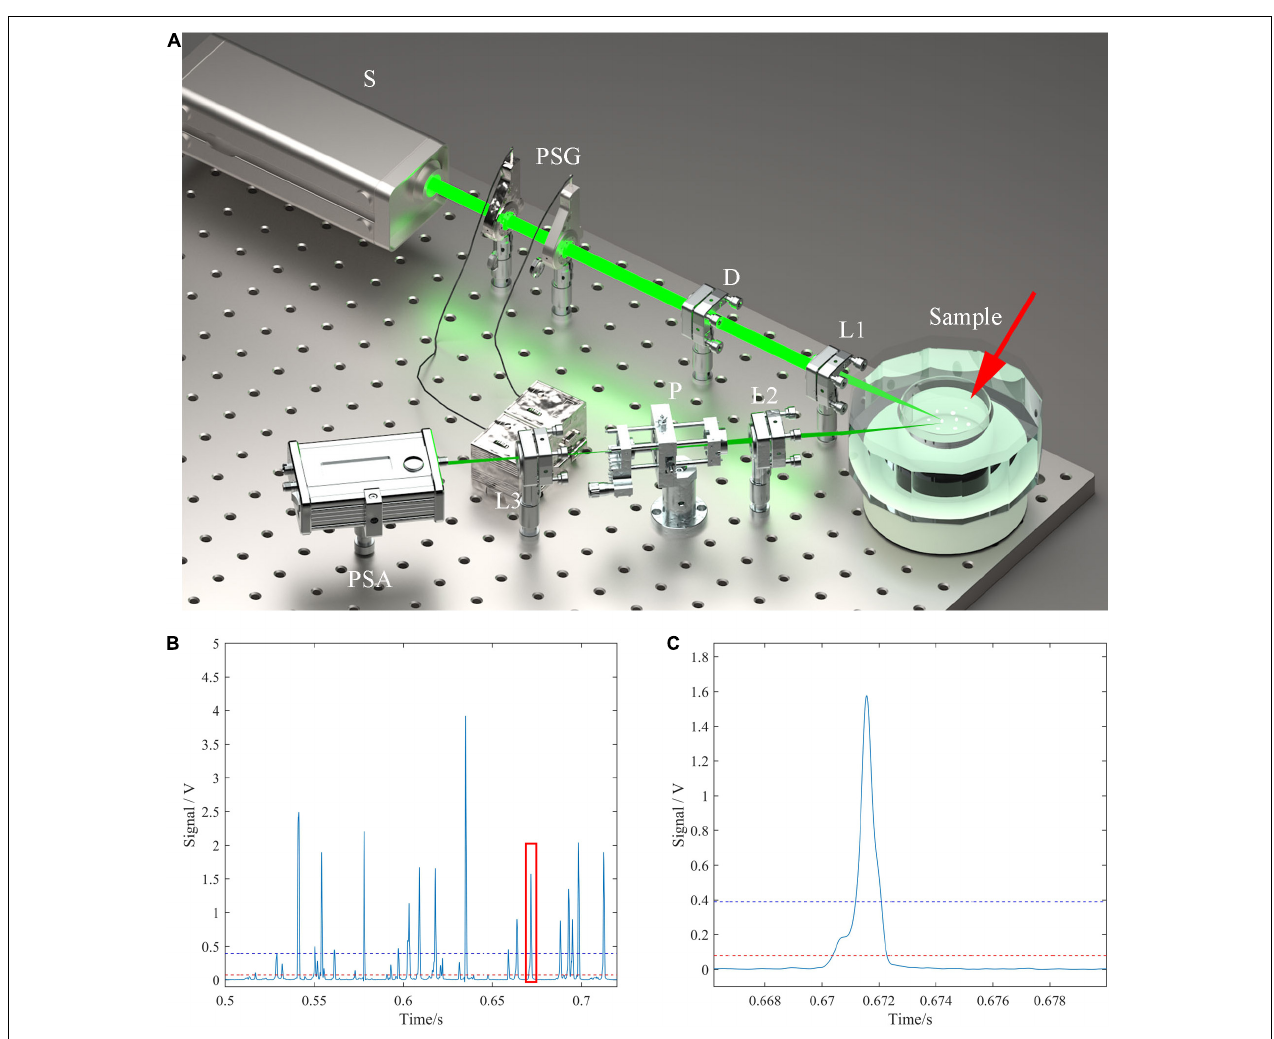
FIGURE 1 | (A) Backward 120 ◦ suspended particle measurement system based on polarized light scattering. S, light source; PSG, polarization state generator; D, diaphragm; L, lens; P, pinhole; PSA, polarization state analysis. (B) Received signals of the setup. (C) The magnification of the temporal pulse. Red line: the background noise; blue line: threshold